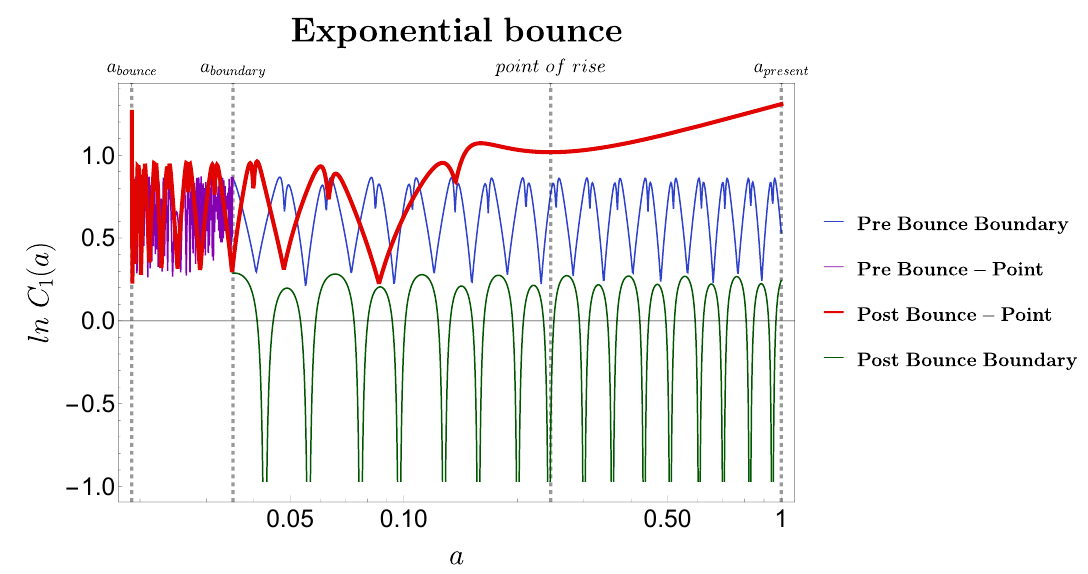
Figure 30: Geodesically weighted complexity in different regions against scale factor.